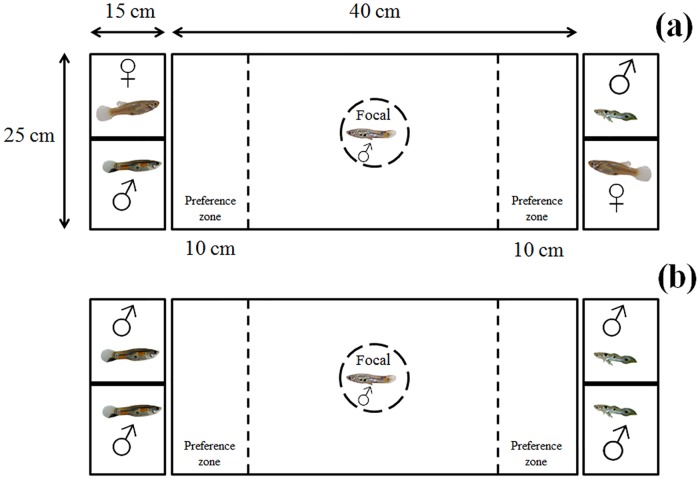
Experimental apparatus.Top-view schematic representation of the experimental apparatus (not to scale), consisting of a central test aquarium holding the focal male and two end compartments holding either (a) a stimulus male and female each in Experiment 1 or (b) two stimulus males each for Experiment 2. During the acclimation and viewing periods (totaling 20 min), the focal male was held in a clear Plexiglas cylinder (represented by the stippled circle) in the centre of the test aquarium. The back line dividing each end compartment denotes an opaque Plexiglas partition preventing the stimulus male and female from interacting socially with each other. The stippled lines denote 10-cm wide preference zones at each end of the test aquarium.